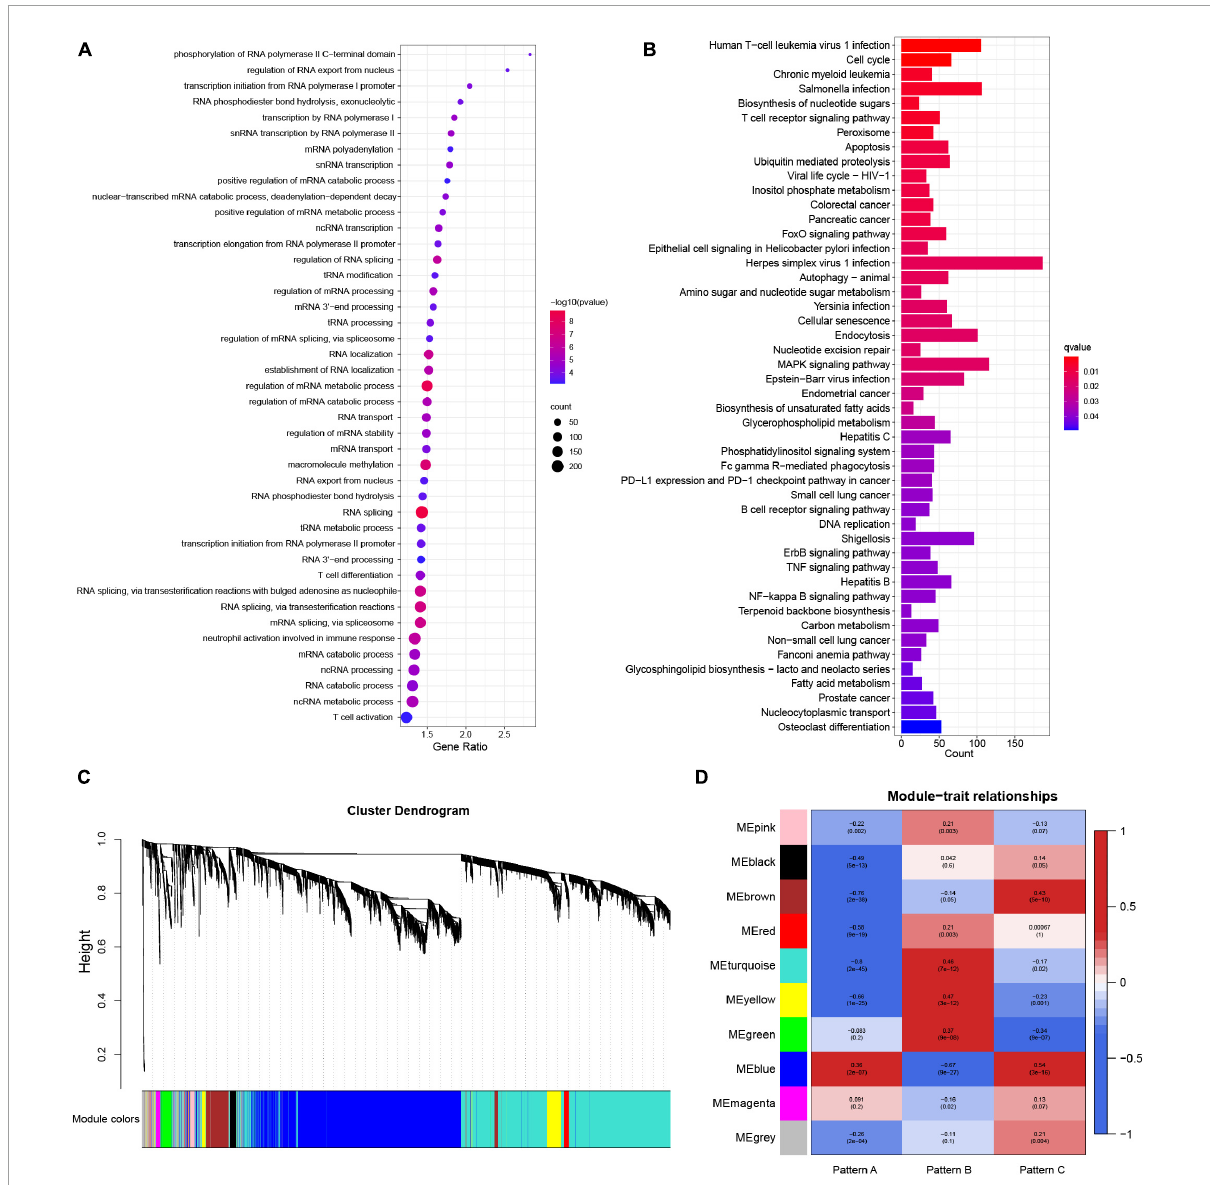
FIGURE7 The underlying biological processes of m 6 A modification-related genes and weighted gene correlation network analysis (WGCNA) of the top 25% variation genes. (A) Partial results of Gene Ontology (GO) enrichment analysis for m 6 A modification-related genes in terms of biological processes (BP). (B) The Kyoto Encyclopedia of Genes and Genomes (KEGG) pathway analysis of m 6 A modification-related genes. (C) Identified modules by WGCNA. (D) Relationships between modules and